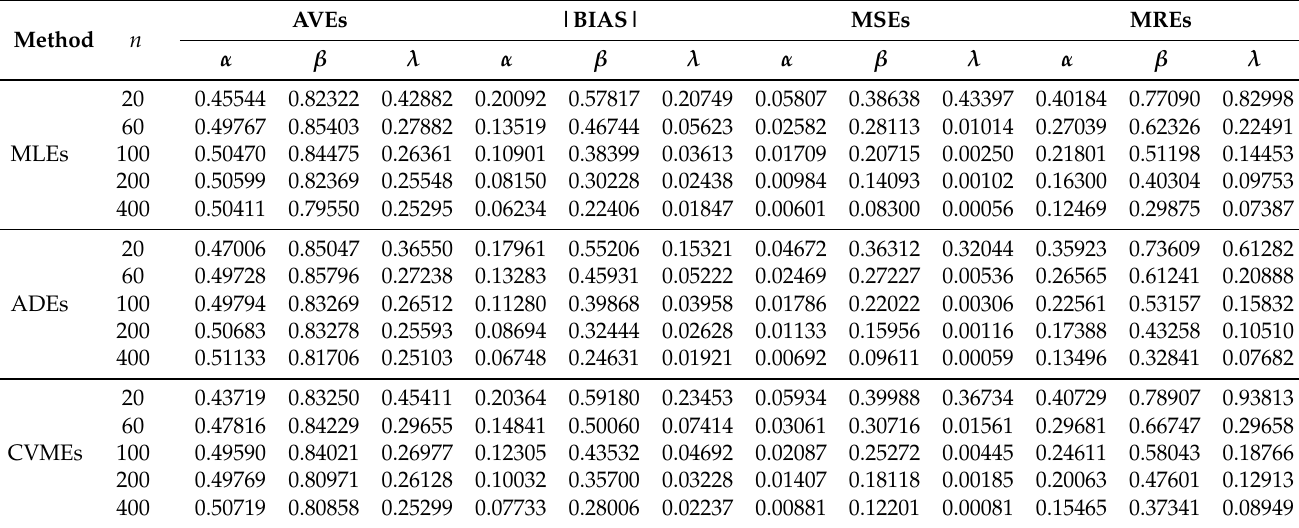
Table 2. Numerical values of the Ex-LL distribution for the parameters α = 0.25, β = 0.75, λ = 0.5. Method